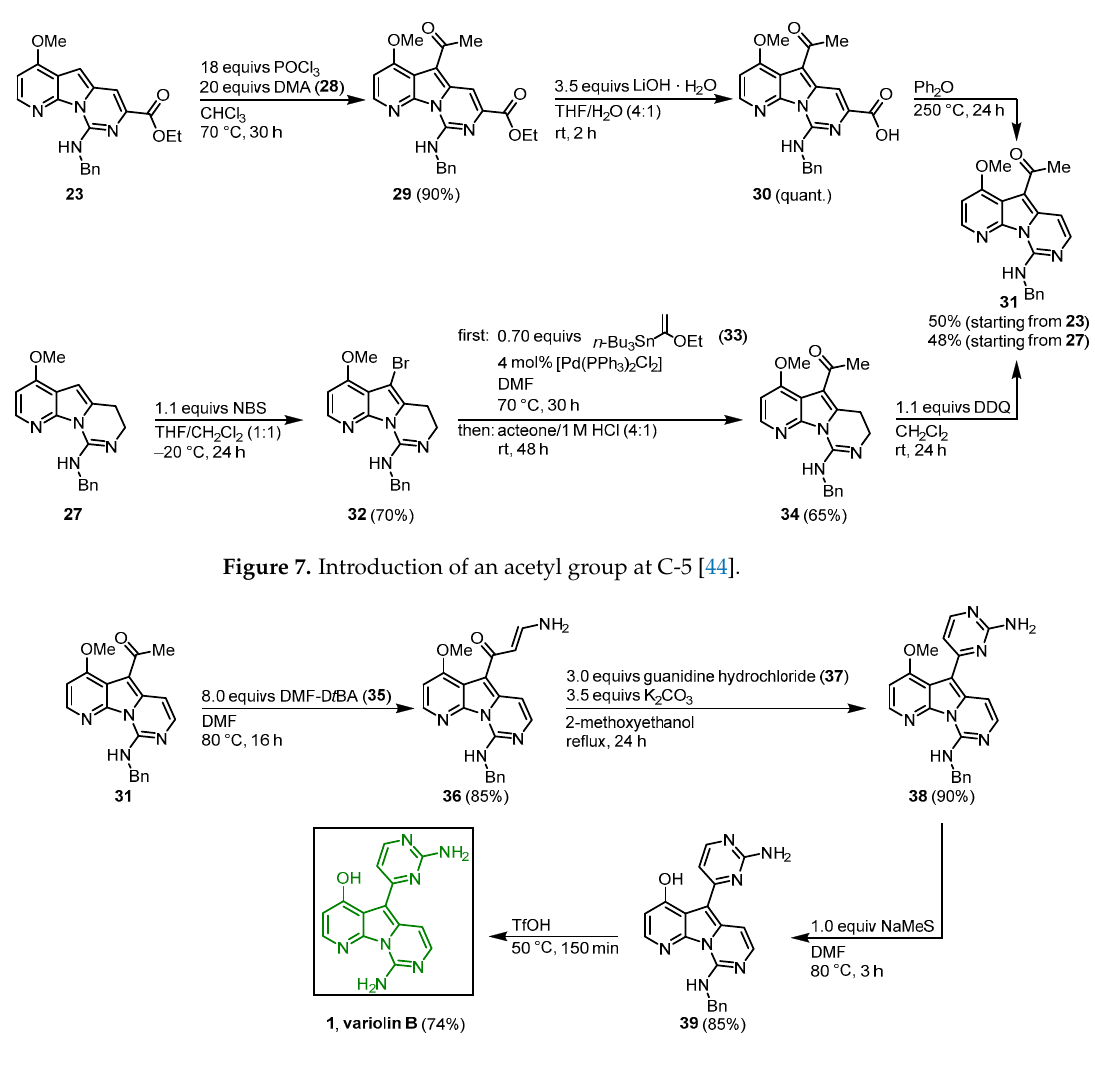
Figure 8. Synthesis of the 2-aminopyrimidine ring to give access to variolin B ( 1 ) [44].